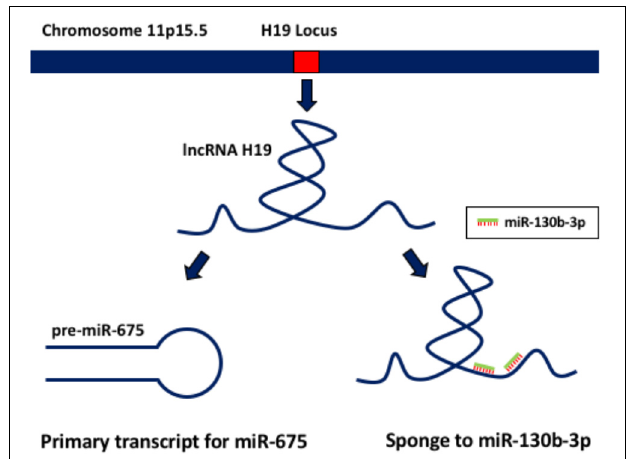
FIGURE 1 | lncRNA H19 functions. This lncRNA acts both as a primary transcript giving rise to miR-675, and also as a sponge to miR-130b-3p.